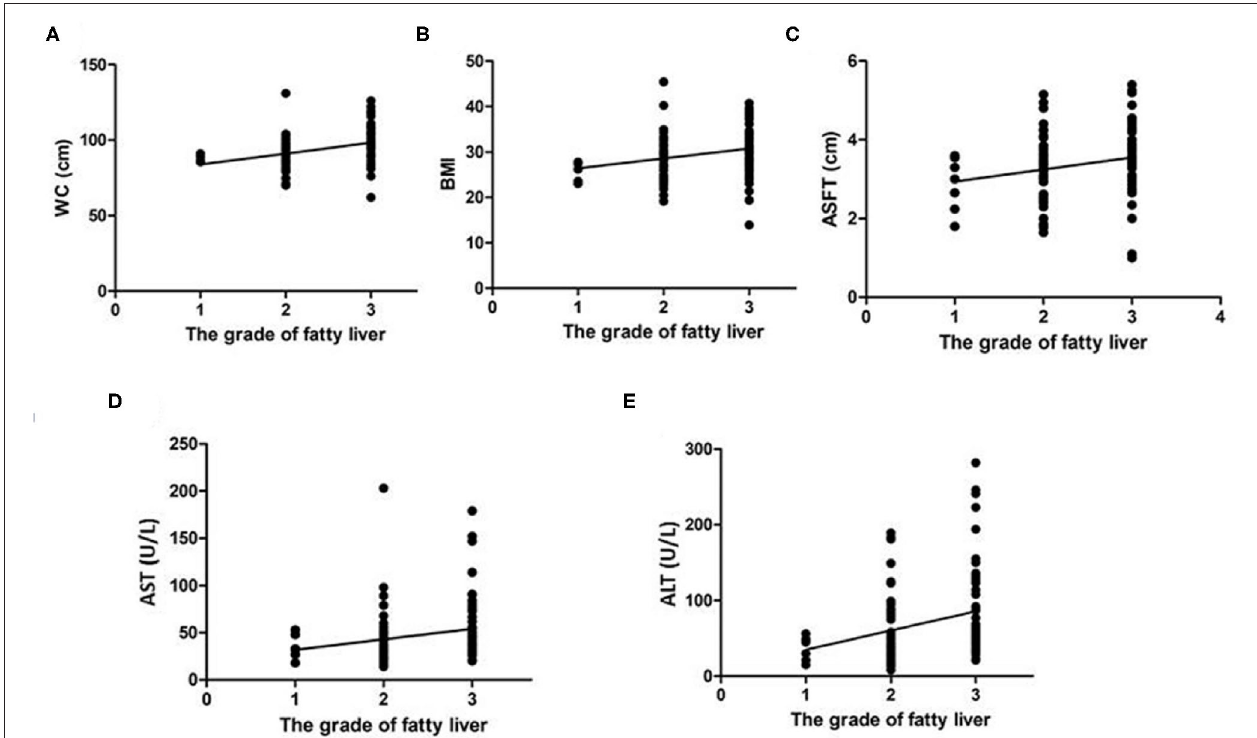
FIGURE 3 | Linear regression analysis of the correlation of WC (A) , BMI (B), ASFT (C) , AST (D) , and ALT (E) with the severity of fatty liver in children with NAFLD. The values of all the determinants are associated with the severity of fatty liver with statistical significance ( p < 0.05).